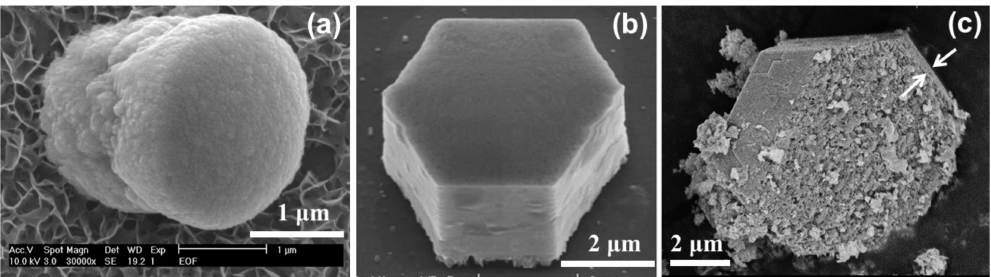
Figure 3. SEM images of ( a ) a polycrystalline aggregate, ( b ) a typical hexagonal microdisk of ZnO, and ( c ) a crushed open ZnO microdisks with reaction time of 5 days. The arrows indicate the thickness of the single crystal shell. Reproduced from [30] with permission from The Royal Society of